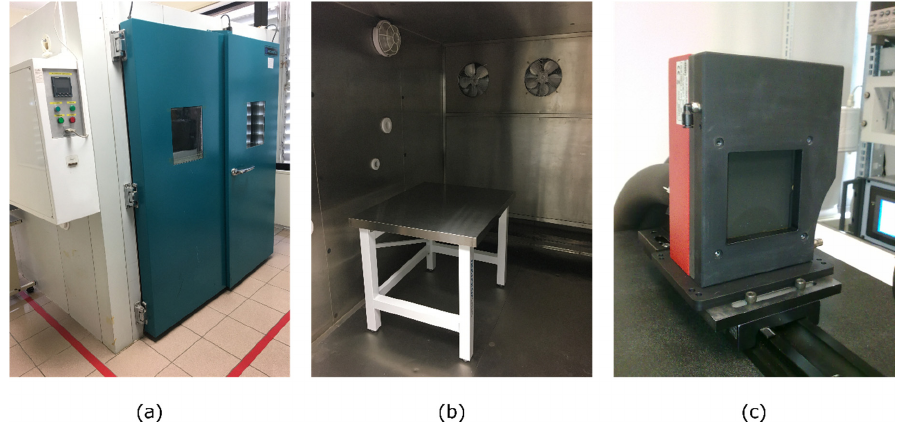
Figure 3. Laboratory facilities: ( a ) Dycometal WALK-IN MOD entrance door; ( b ) Workbench inside the climatic chamber; ( c ) DCN1000-L3 laboratory blackbody .